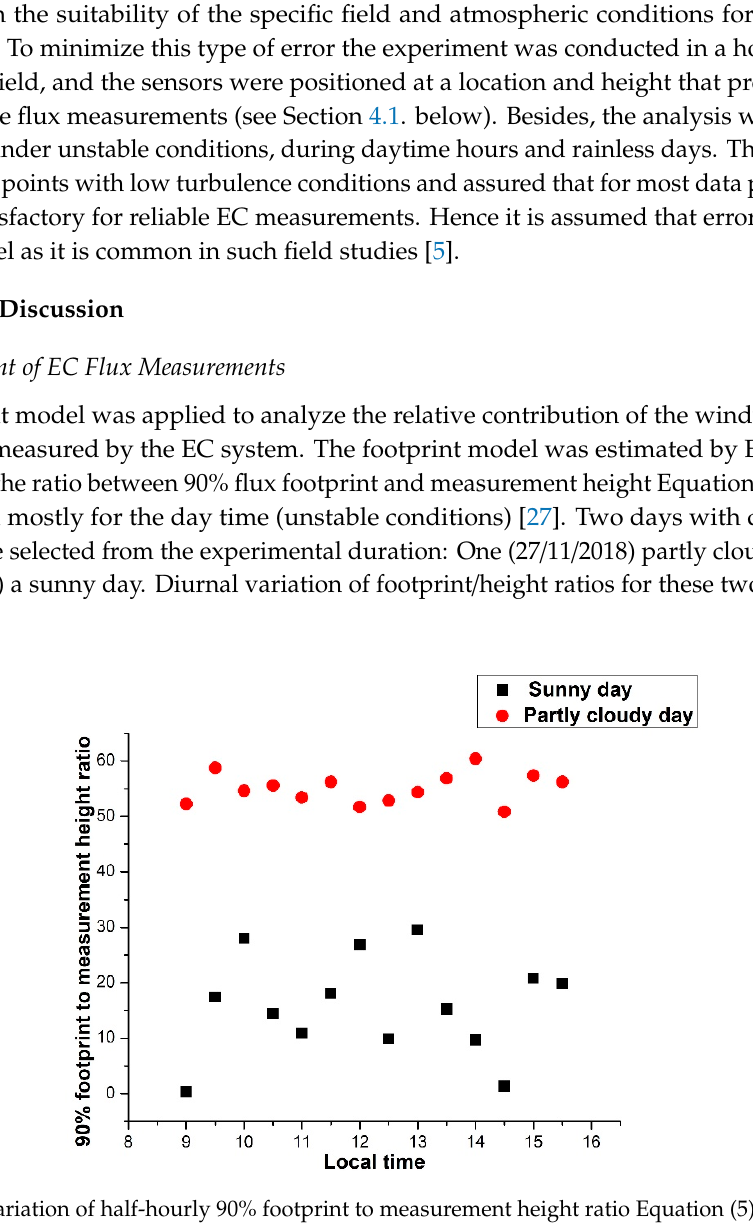
Figure 4. Variation of half ‐ hourly 90% footprint to measurement height ratio Equation (5) for two days one partly cloudy (27/11/2018) and the other with a clear sky (sunny day) (18/10/2018) [28].